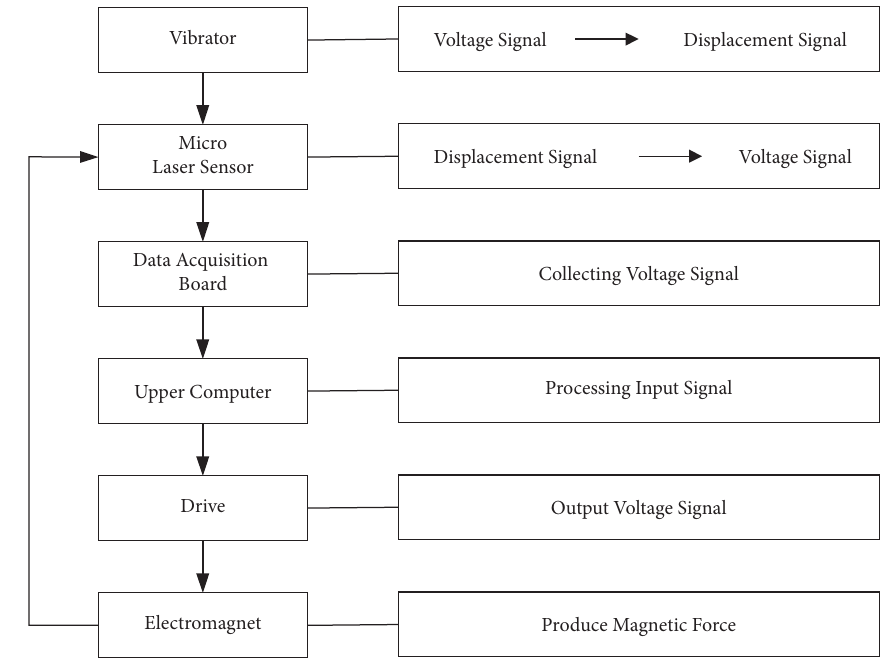
Figure 10: Data acquisition hardware system. Table 5: Main